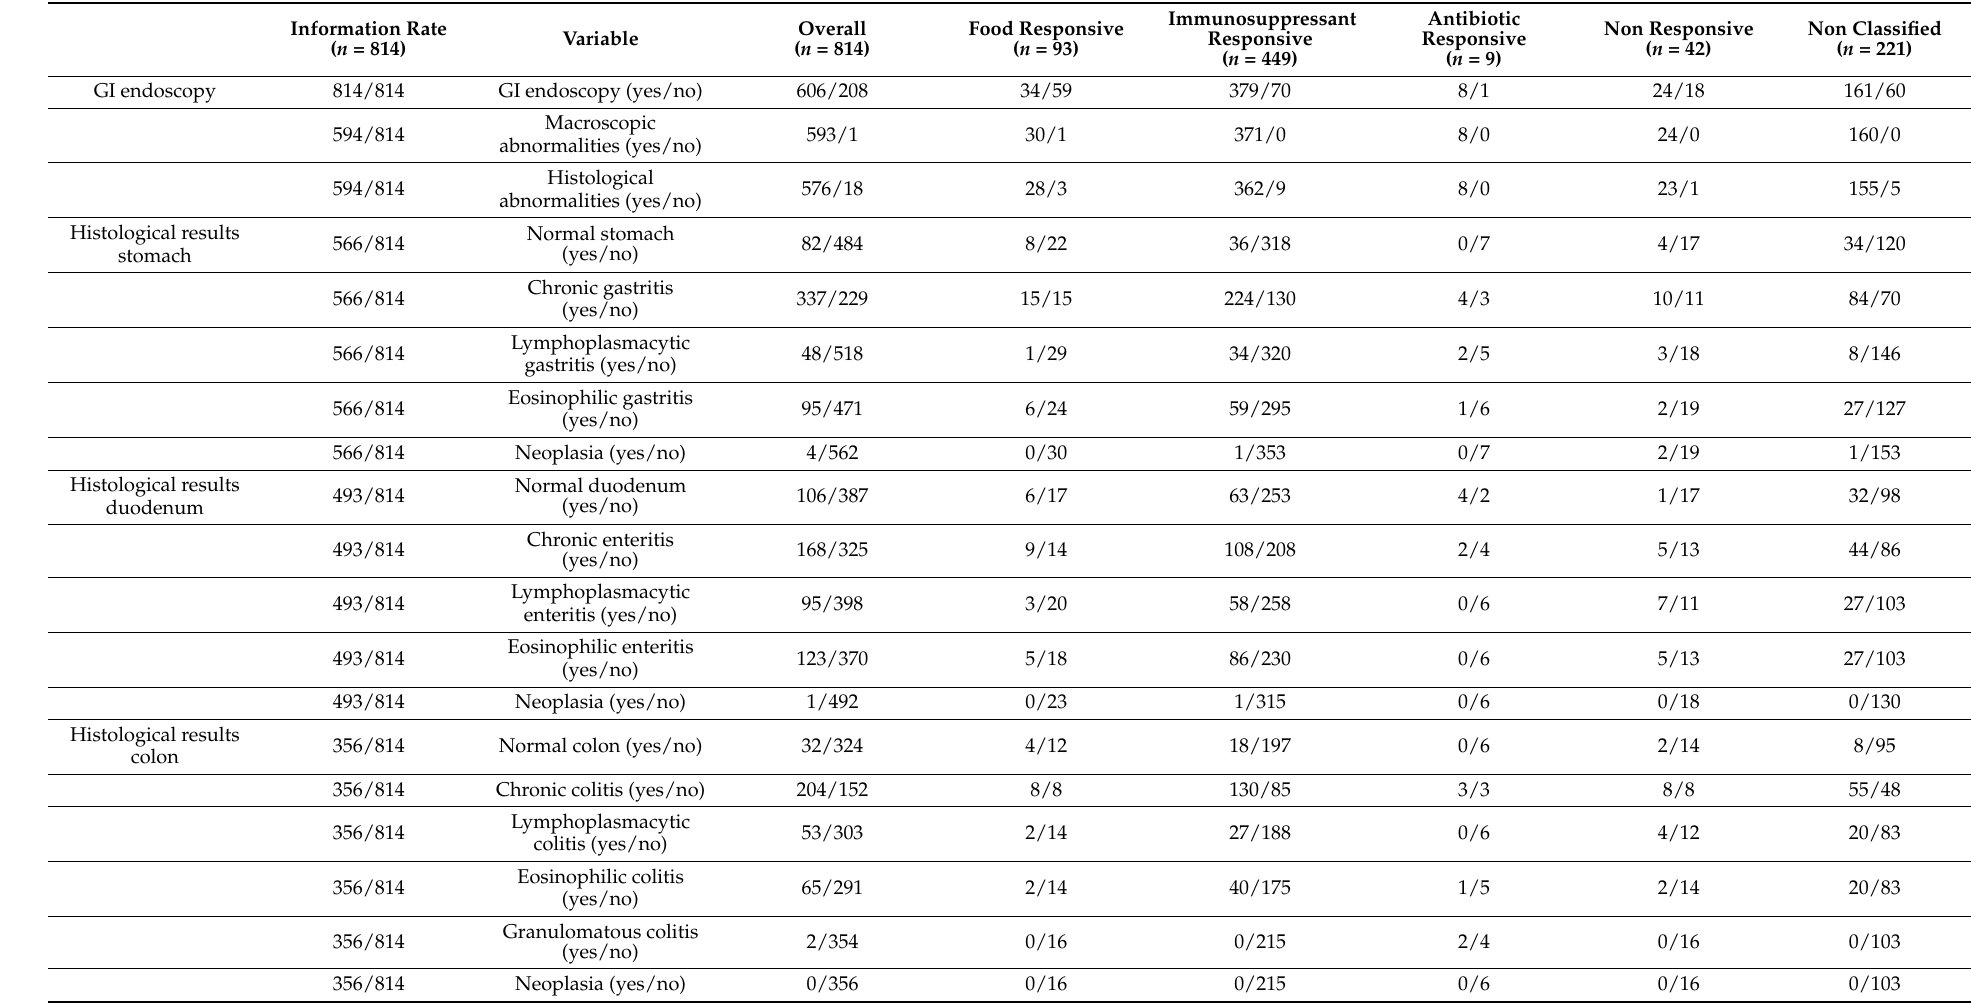
Table 3. Summary of gastrointestinal (GI) endoscopy findings and histological findings by treatment outcome